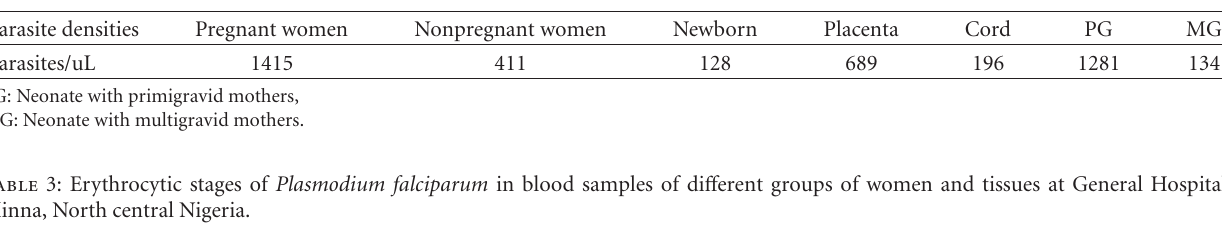
Table 2: Average parasite densities (Parasites/uL) of blood of di ff erent groups of women and tissues at General Hospital Minna, North central Nigeria.